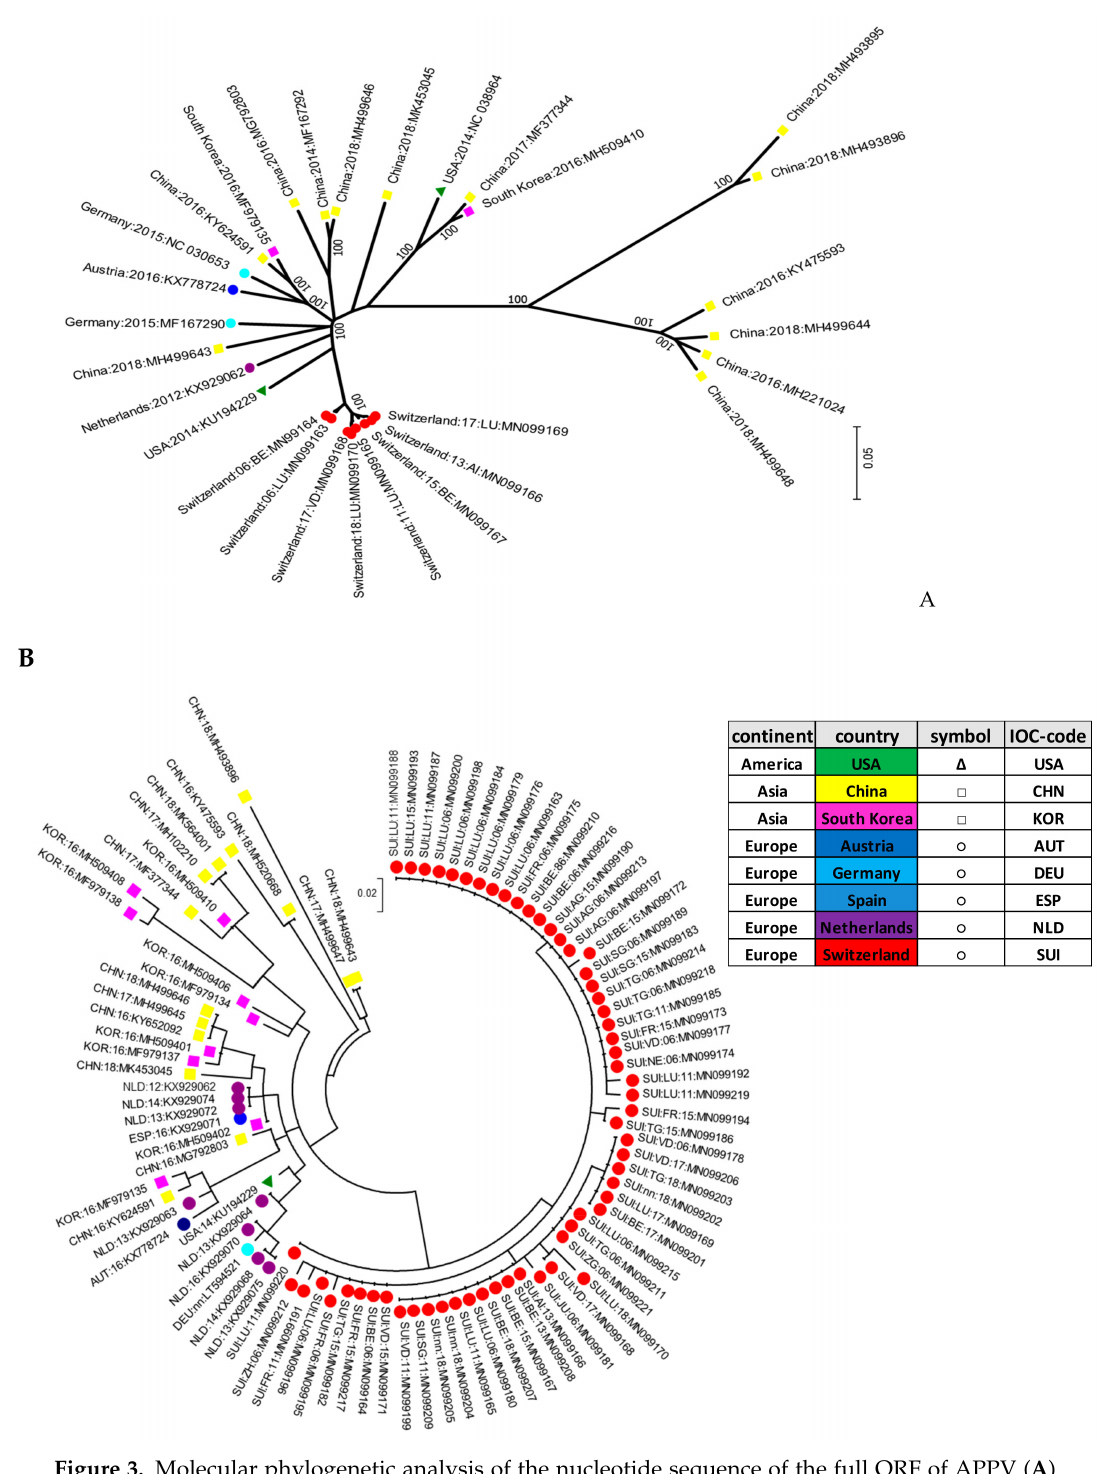
Figure 3. Molecular phylogenetic analysis of the nucleotide sequence of the full ORF of APPV ( A ) or of a fragment in the 5 (cid:48) UTR ( B ). Initial tree(s) for the heuristic search were obtained automatically by applying Neighbor-Join and BioNJ algorithms to a matrix of pairwise distances estimated using the maximum composite likelihood (MCL) approach. A discrete gamma distribution was used to model the evolutionary rate di ff erences among the sites. The trees were drawn to scale, with branch lengths measured in the number of substitutions per site. All positions containing gaps and missing data were eliminated. The percentage of trees in which the associated taxa clustered together is shown next to the branches. In the final dataset, there were a total of 10,810 positions encompassing the